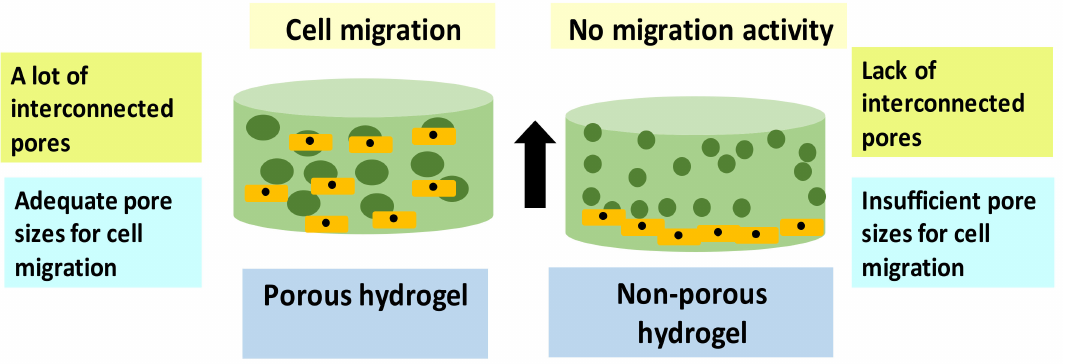
Figure 8. A comparison between cell migration activity in the porous and non-porous